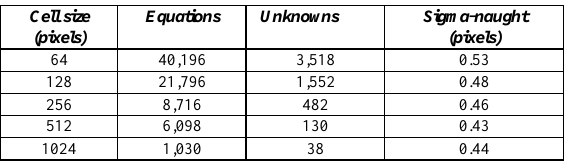
Table 3. Results with the progressive feature decimation.